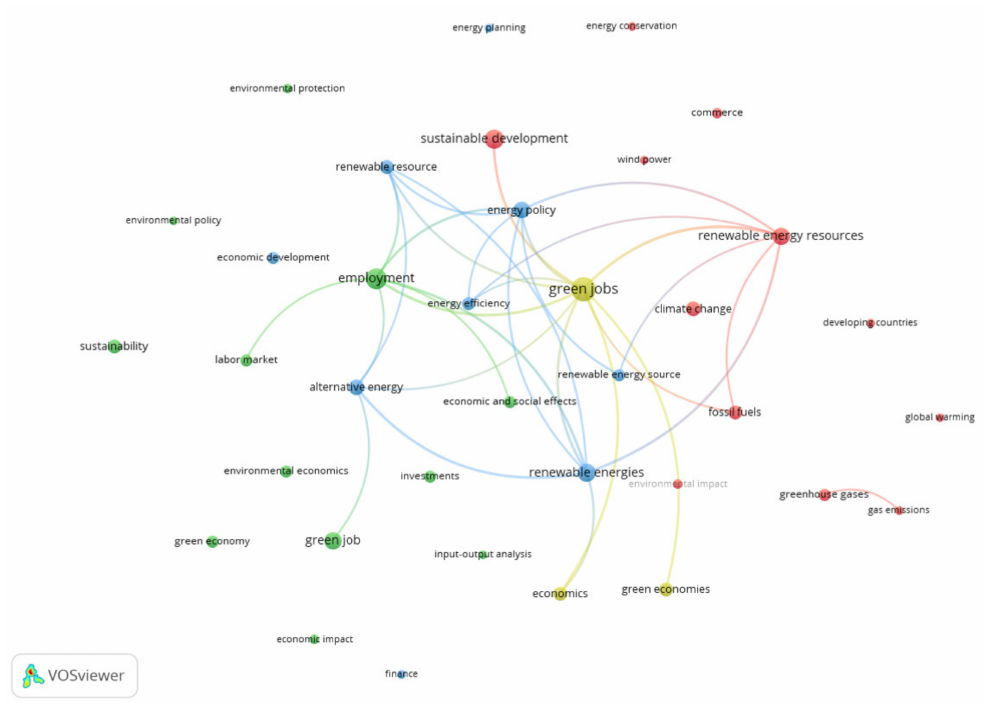
Figure 7. Keywords with a total link strength of five or more. Source: Authors’ elaboration in VOSviewer software (1.6.18